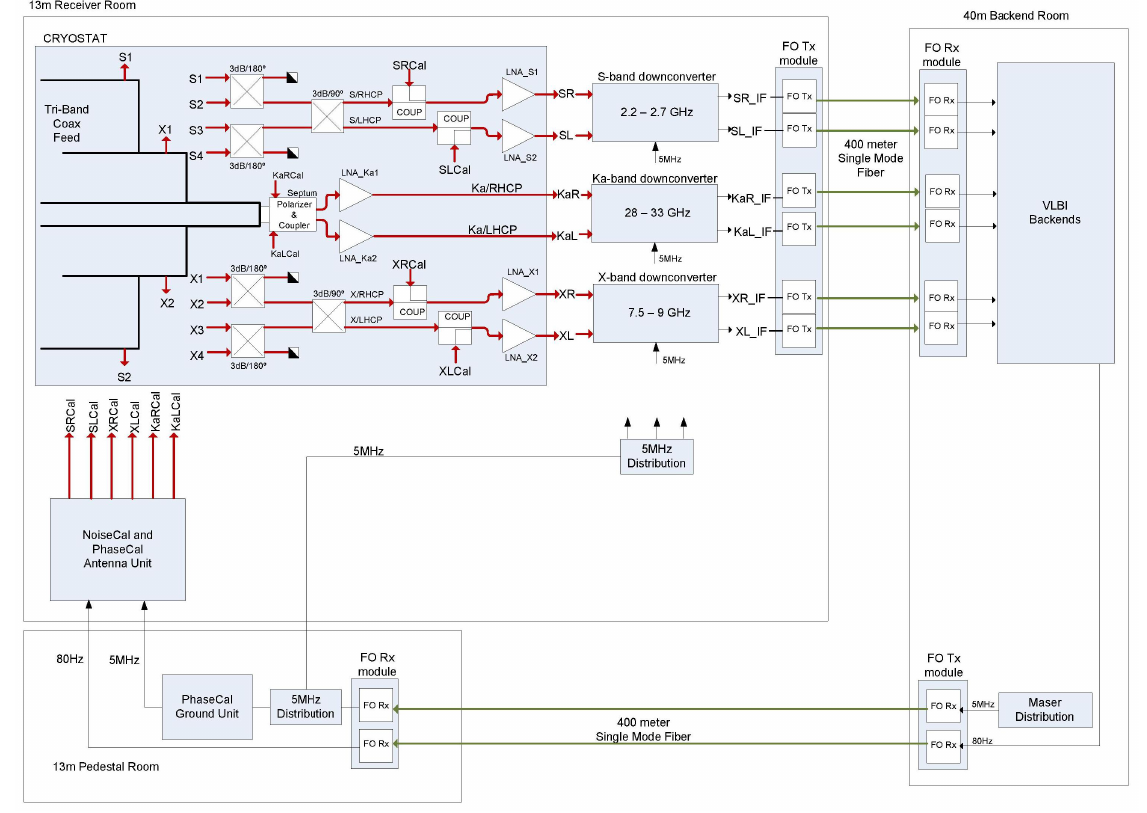
Figure 2. Tri-band receiver block